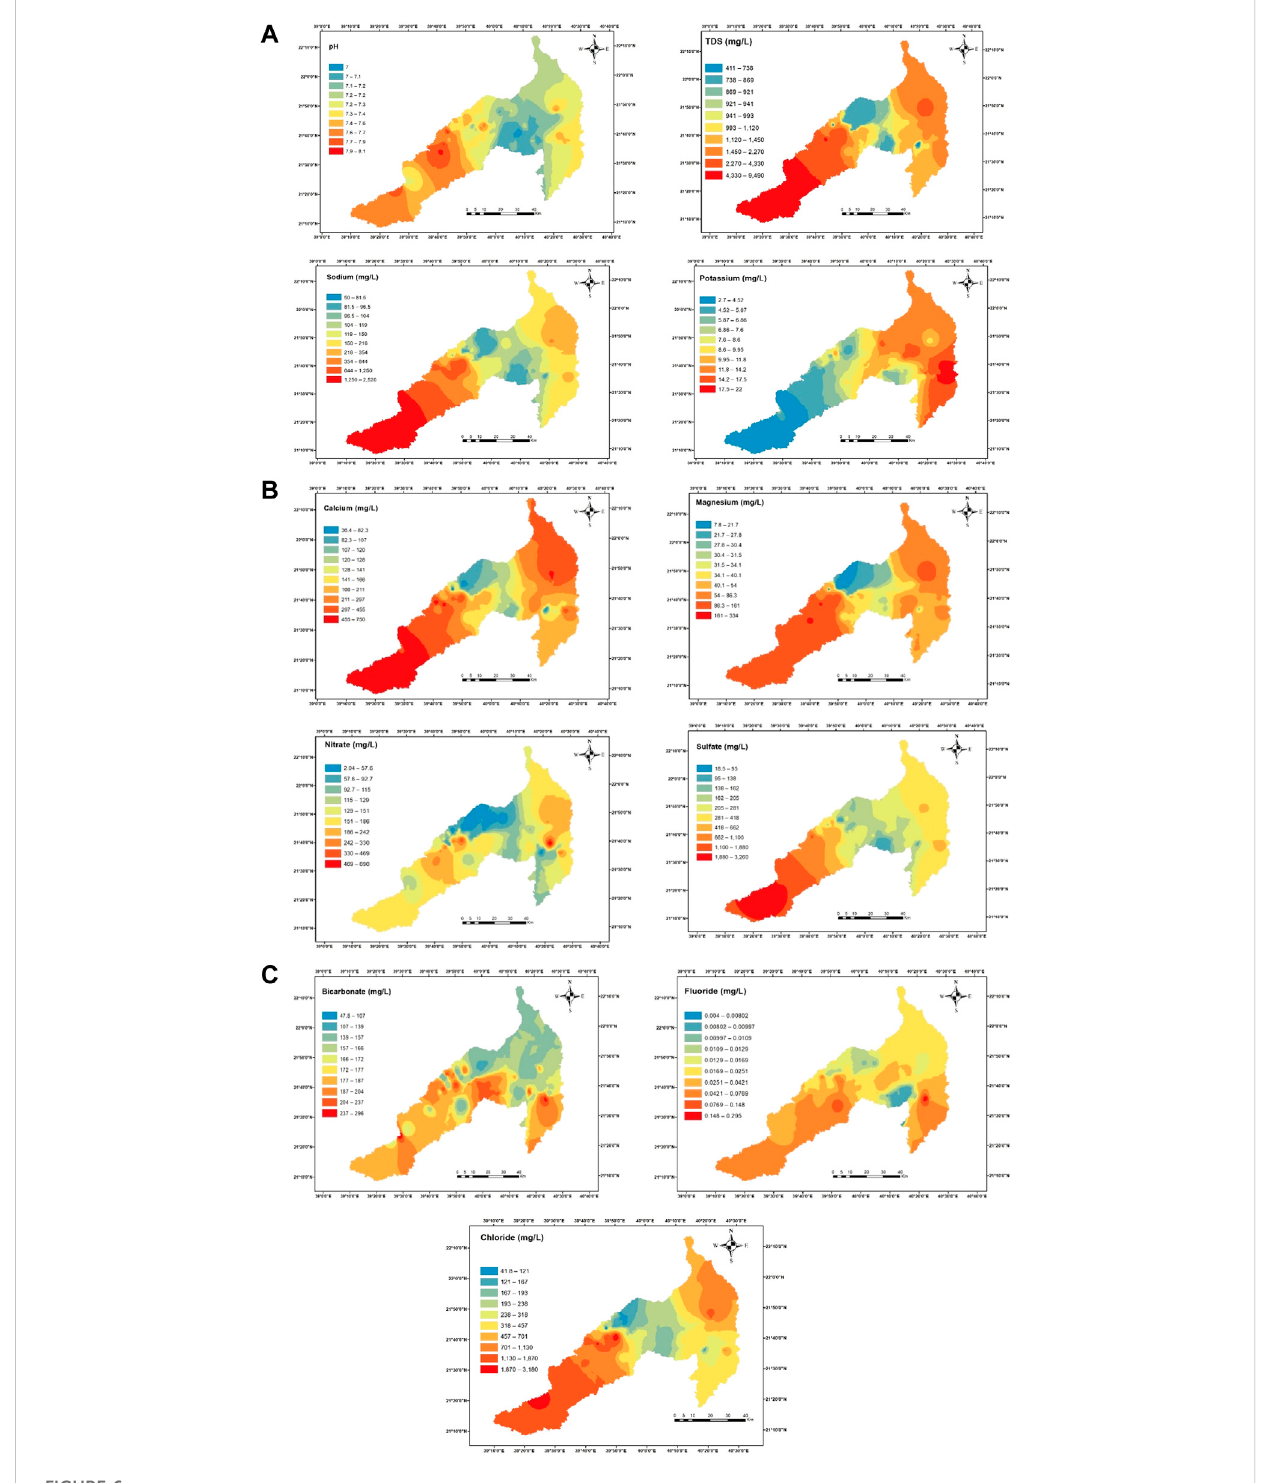
FIGURE 6 (A – C) Spatial distribution of physico-chemical parameters along the study